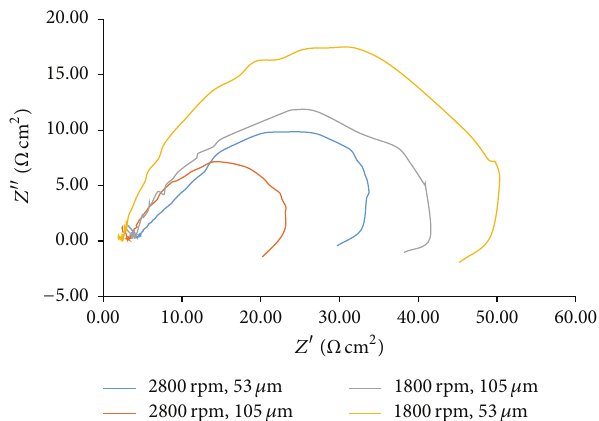
Figure 5: Nyquist diagrams of AISI 4330 steel electrode at different rotatingspeedsandparticlesizesinpH3solutionscontaining3 wt.% NaCl with a constant concentration of 10 wt.% silica particles in deionized water.